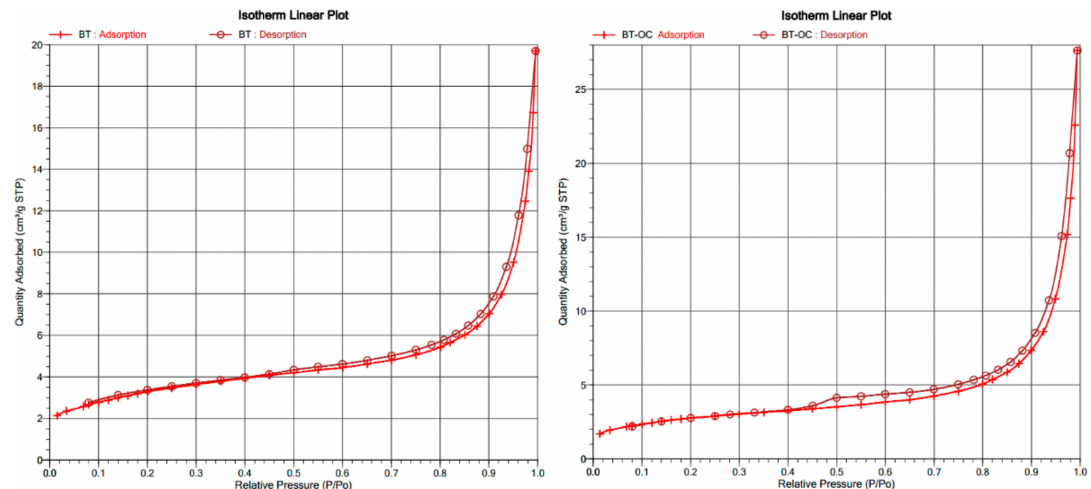
Figure 4. N 2 adsorption-desorption isotherms of BT and BT-OC